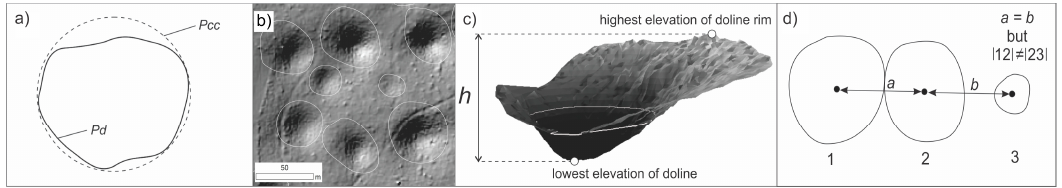
Figure 2. ( a ) The parameters of a doline circularity index; ( b ) The area of a doline planar shape, visually determined from LiDAR data; ( c ) The acquisition of the depth parameter; ( d ) The influence of doline size on density calculation.